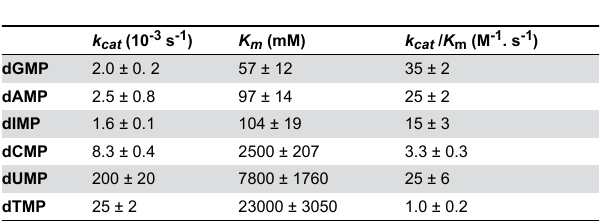
Table 2. Kinetic parameters of the human DNPH1 with different 2'-deoxynucleosides 5’-monophosphates as substrates.